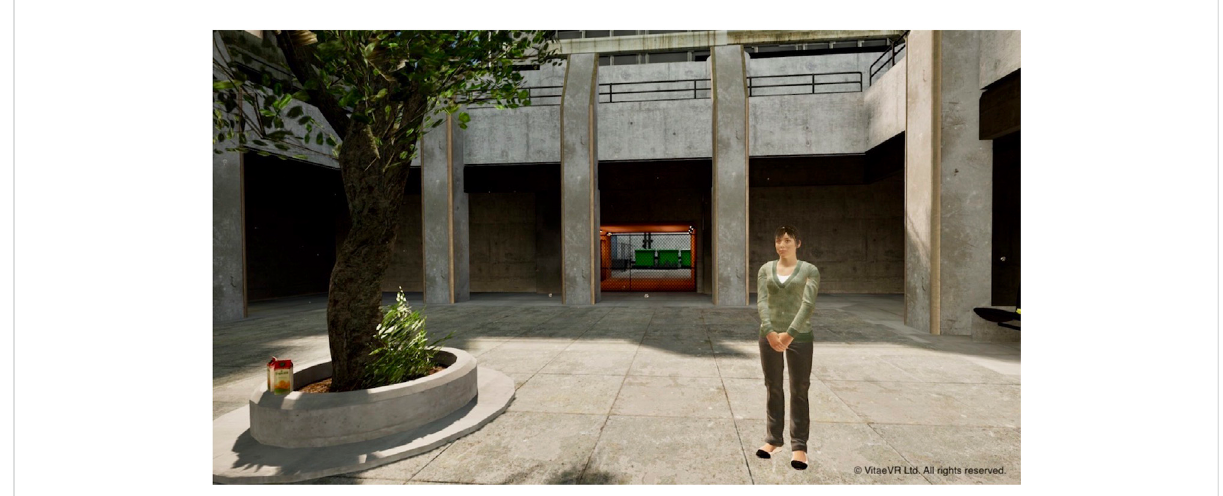
FIGURE 1 VStoreAcclimatisationCourtyard.©Porffyetal.(2022).OriginallypublishedintheJournalofMedicalInternetResearch(https://www.jmir.org),